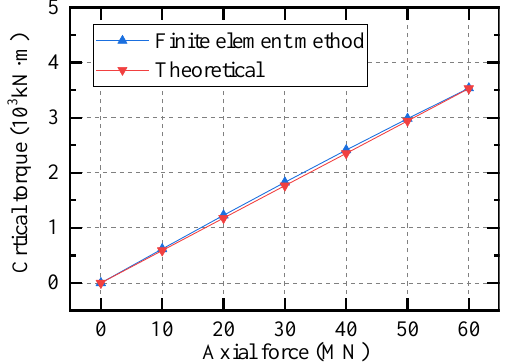
Figure 7. The critical torque obtained by the finite element method and theoretical calculation.